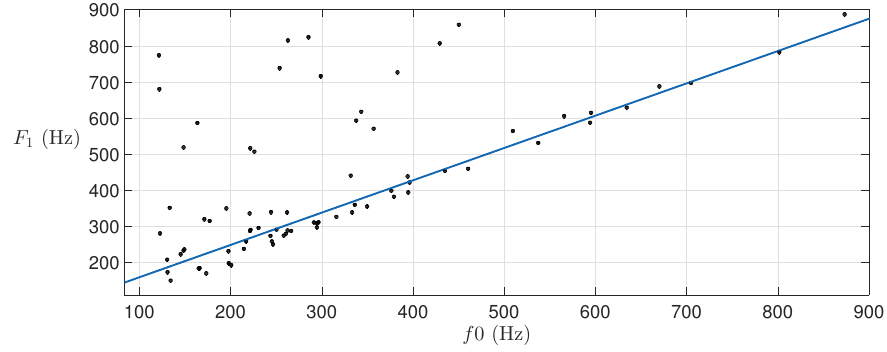
Figure 3. F 1 evolution with pitch ( f 0), harmonic